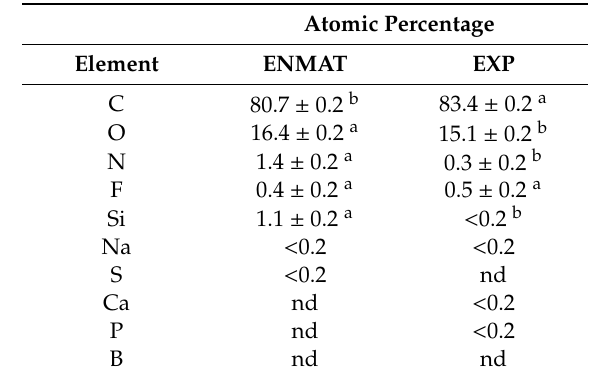
Table 5. Atomic percentages, based on the spectral analysis, of the surface of PHBV film purified from R-NF fermented with Hfx. mediterranei DSM1411 (EXP) and of the commercial reference ENMAT ™